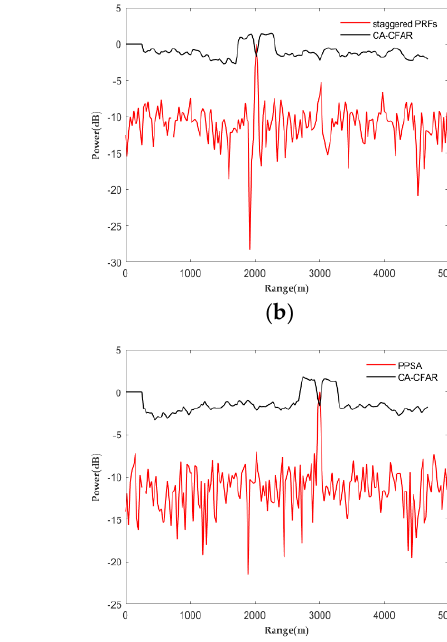
of SPC, ( c ) the result of PPSA, ( d ) the result of PPSA.